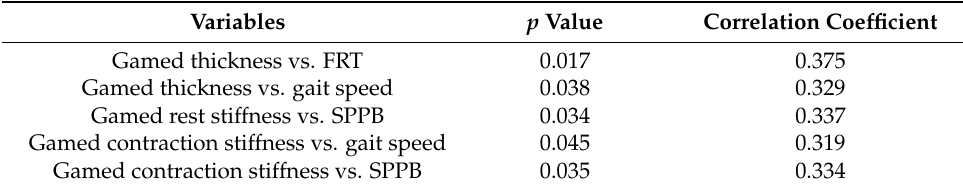
Table 3. Pearson correlations between balance ability muscle thickness and stiffness in the fallers.